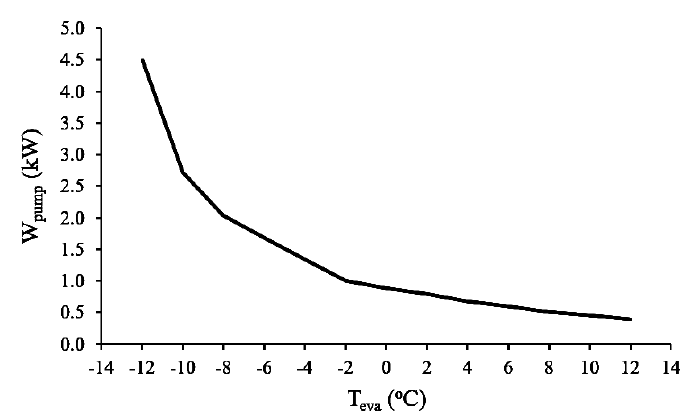
Figure 21. Effect of T eva on thermal loads.